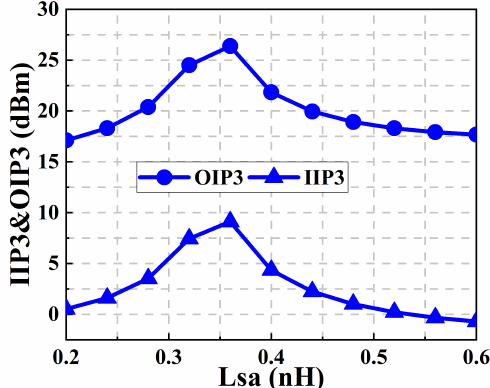
Figure 12. Simulated IIP3 and OIP3 versus L sa of the proposed